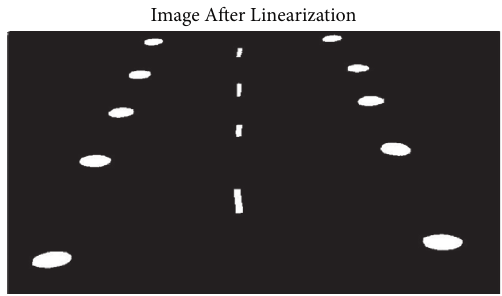
Figure 7: View of the road after threshold linearization.